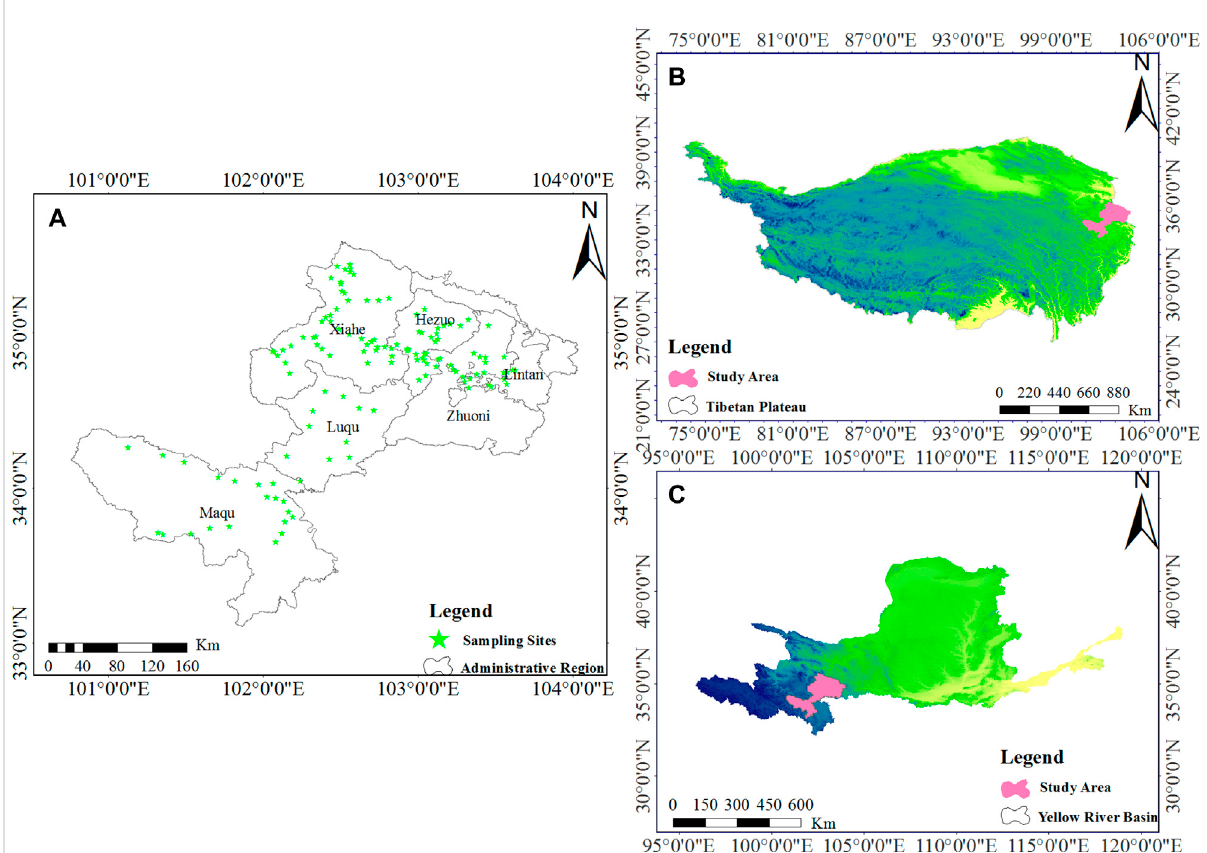
FIGURE 2 Geographical map of the study area. (A) Location of the sampling points, (B) location of the study area on the Tibetan Plateau, and (C) location of the study area on the Yellow River